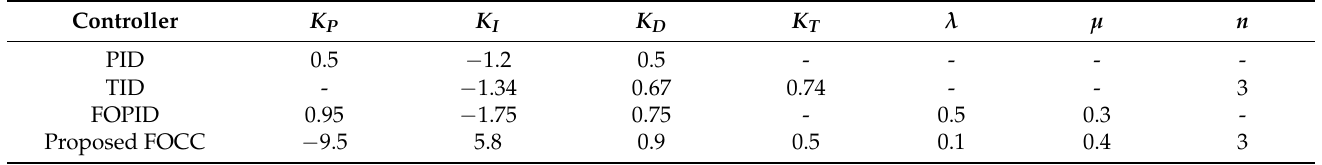
Table 2. Optimal values of the controllers’ parameters using the KA algorithm.